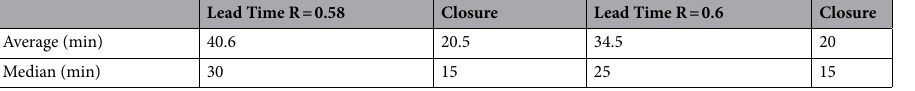
Table 5. Average lead and closure time for the lava fountain episodes from May to December 2021. “Closure” reports the time difference between the declared end and the actual warning of the episodes.